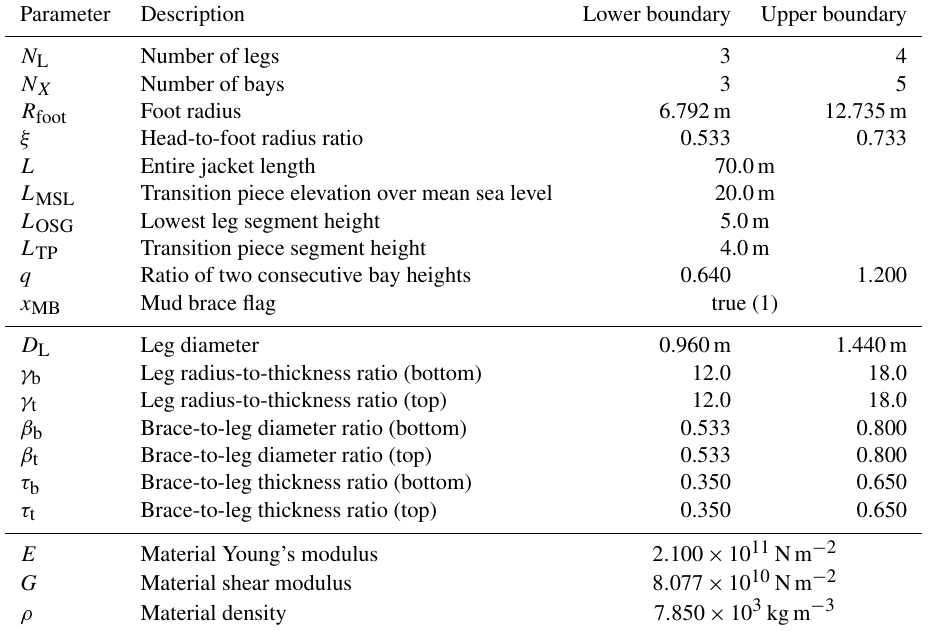
Table 1. Boundaries of jacket model parameters for design of experiments. Topological, tube sizing, and material parameters are separated into groups; single values mean that the corresponding value is held constant.